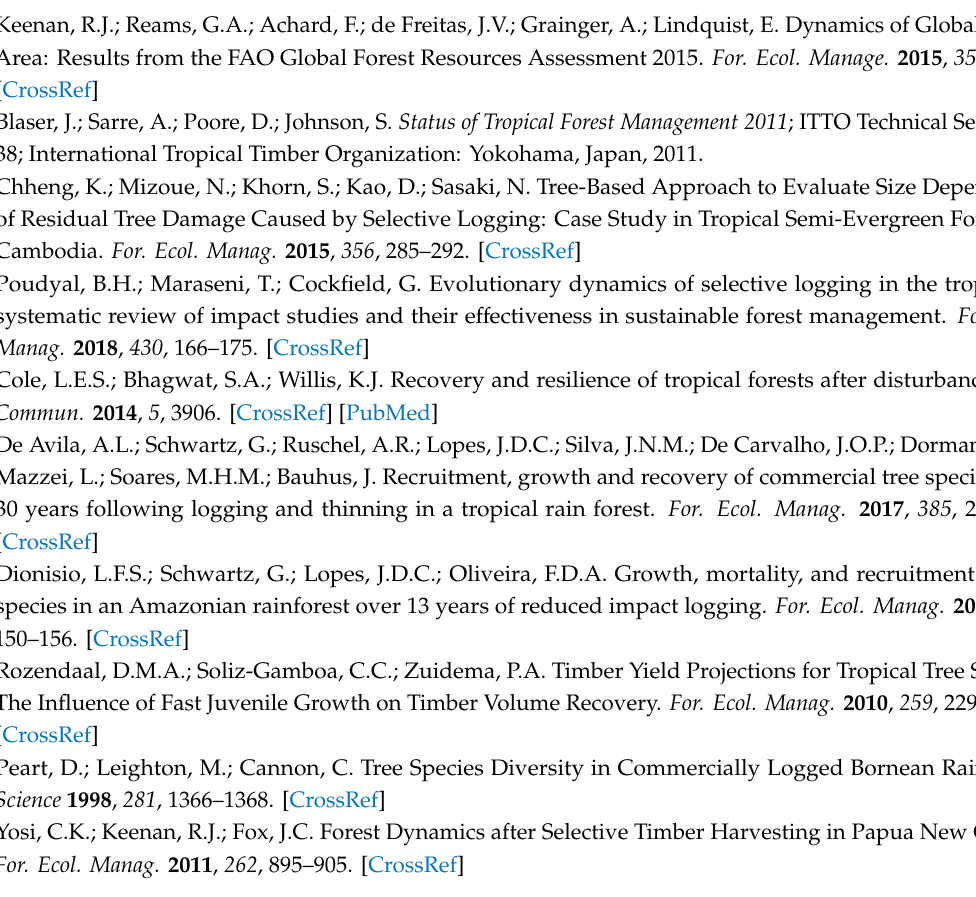
Figure S1: Annual DBH increment for each species group, Table S1: Changes in the density (trees ha -1 ) of trees with DBH ≥ 10 cm for all and each species group., Table S2: Changes in basal area (m2 ha -1 ) of trees with DBH 10 ≥ cm for all and each species group, Table S3: Annual DBH increment (cm year -1 ) for species